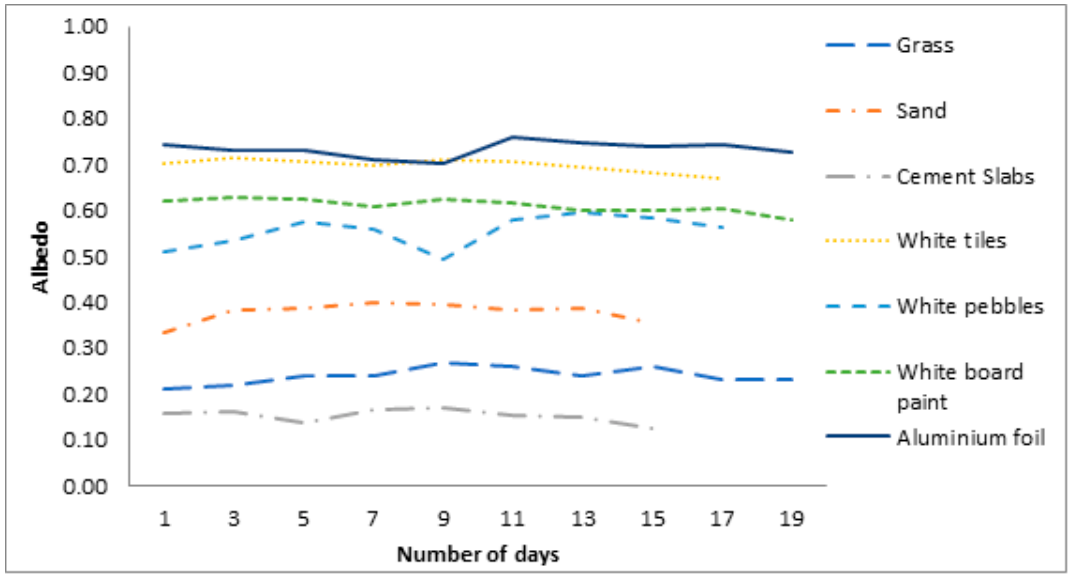
Figure 2. Ageing of materials analysed.